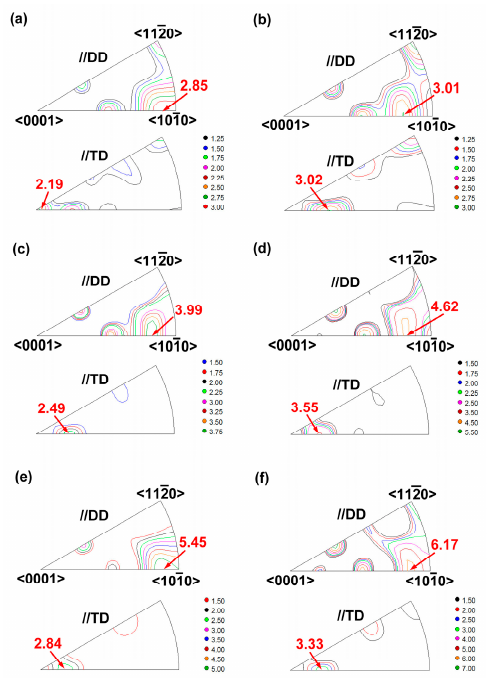
Figure 4. Representation of inverse pole figures (IPFs) corresponding to warm-drawn and IA states: ( a ) as-received state; ( b ) as-received + IA state; ( c ) 30% warm-drawn state; ( d ) 30% warm-drawn + IA state; ( e ) 60% warm-drawn state; ( f ) 60% warm-drawn + IA state.